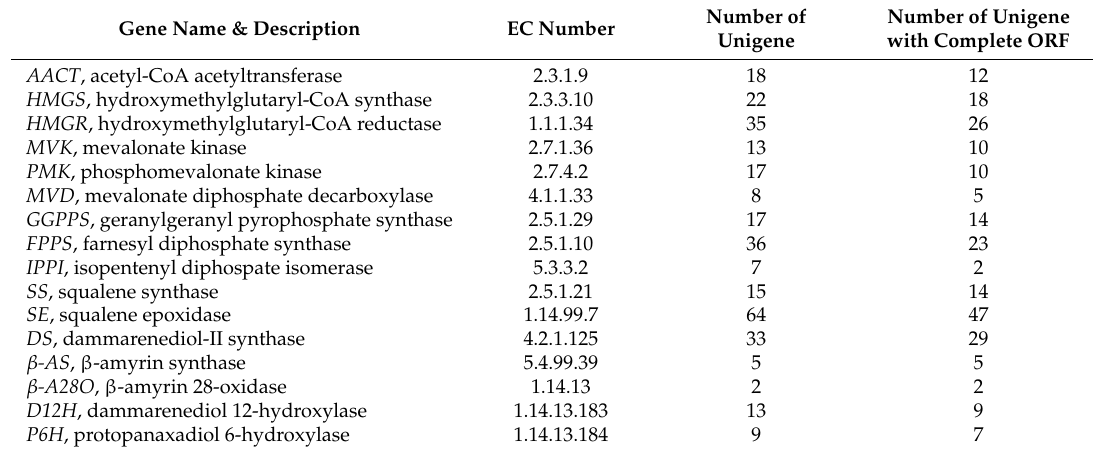
Table 1. Unigenes involved in triterpene saponin biosynthesis in P. ginseng